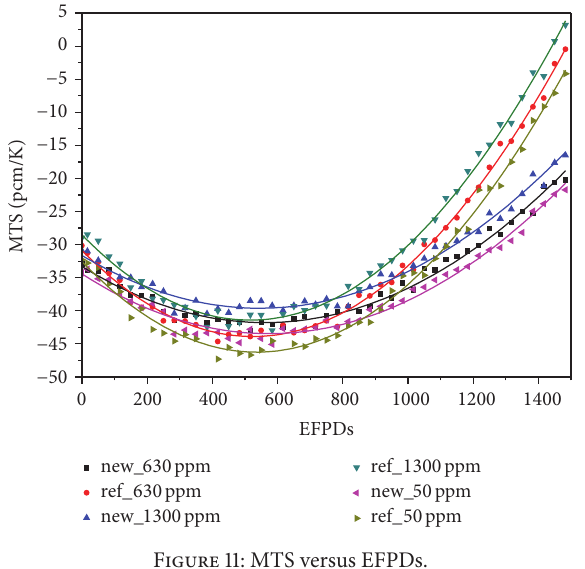
Figure 11: MTS versus EFPDs.